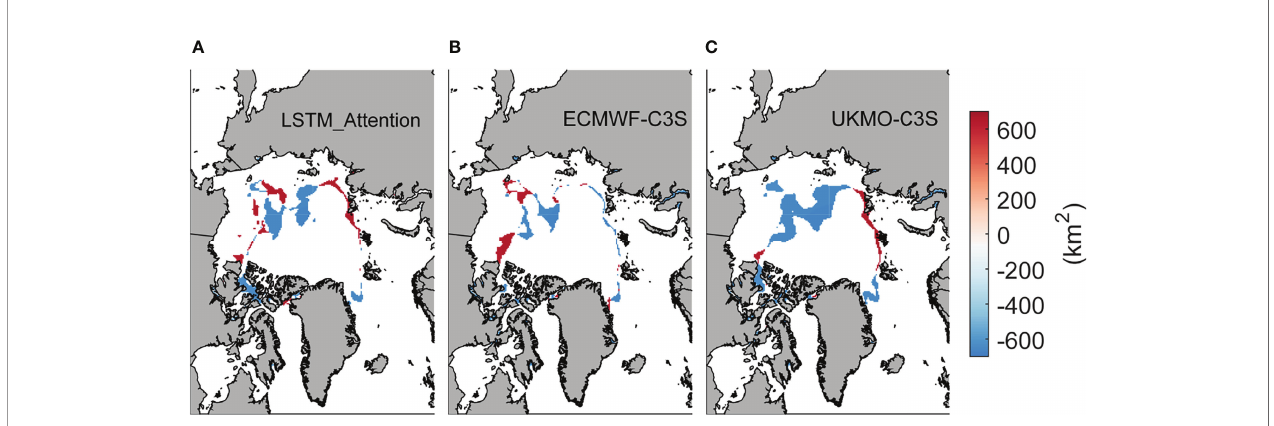
FIGURE 14 | The spatial structure of gridded OE (red area) and UE (blue area) of sea ice forecast in September 2016 using LSTM_Attention (A) , ECMWF-C3S (B) , and UKMO-C3S (C) , respectively, at 1-month lead time. Note that the sign of UE has been reversed from positive to negative for